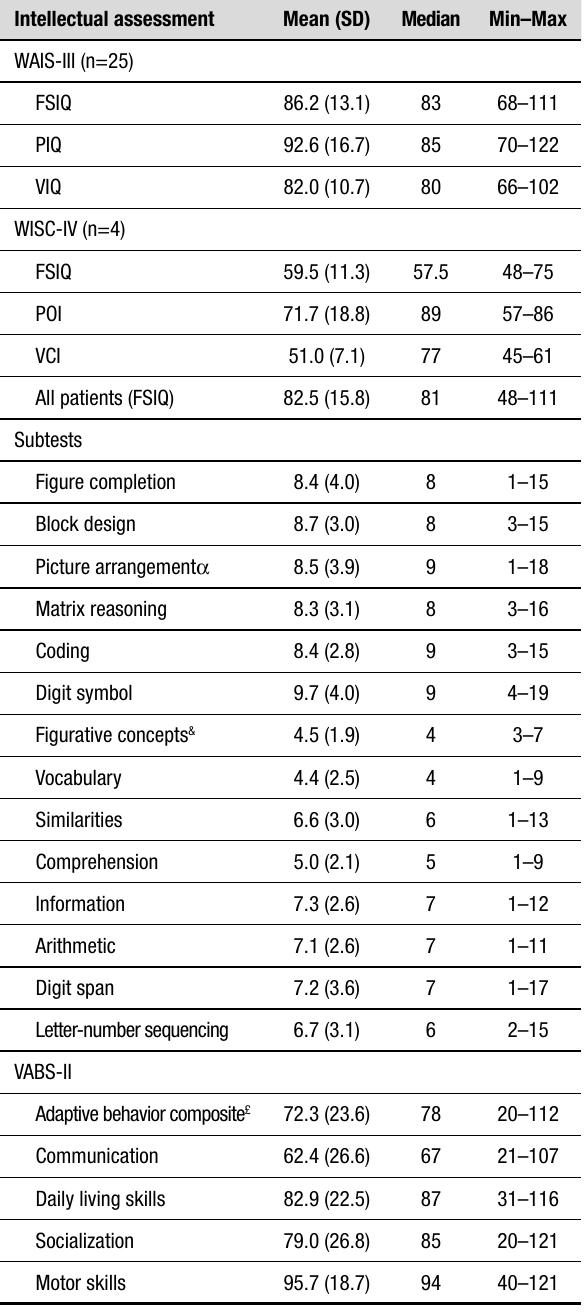
Table 2. Intelligence data of